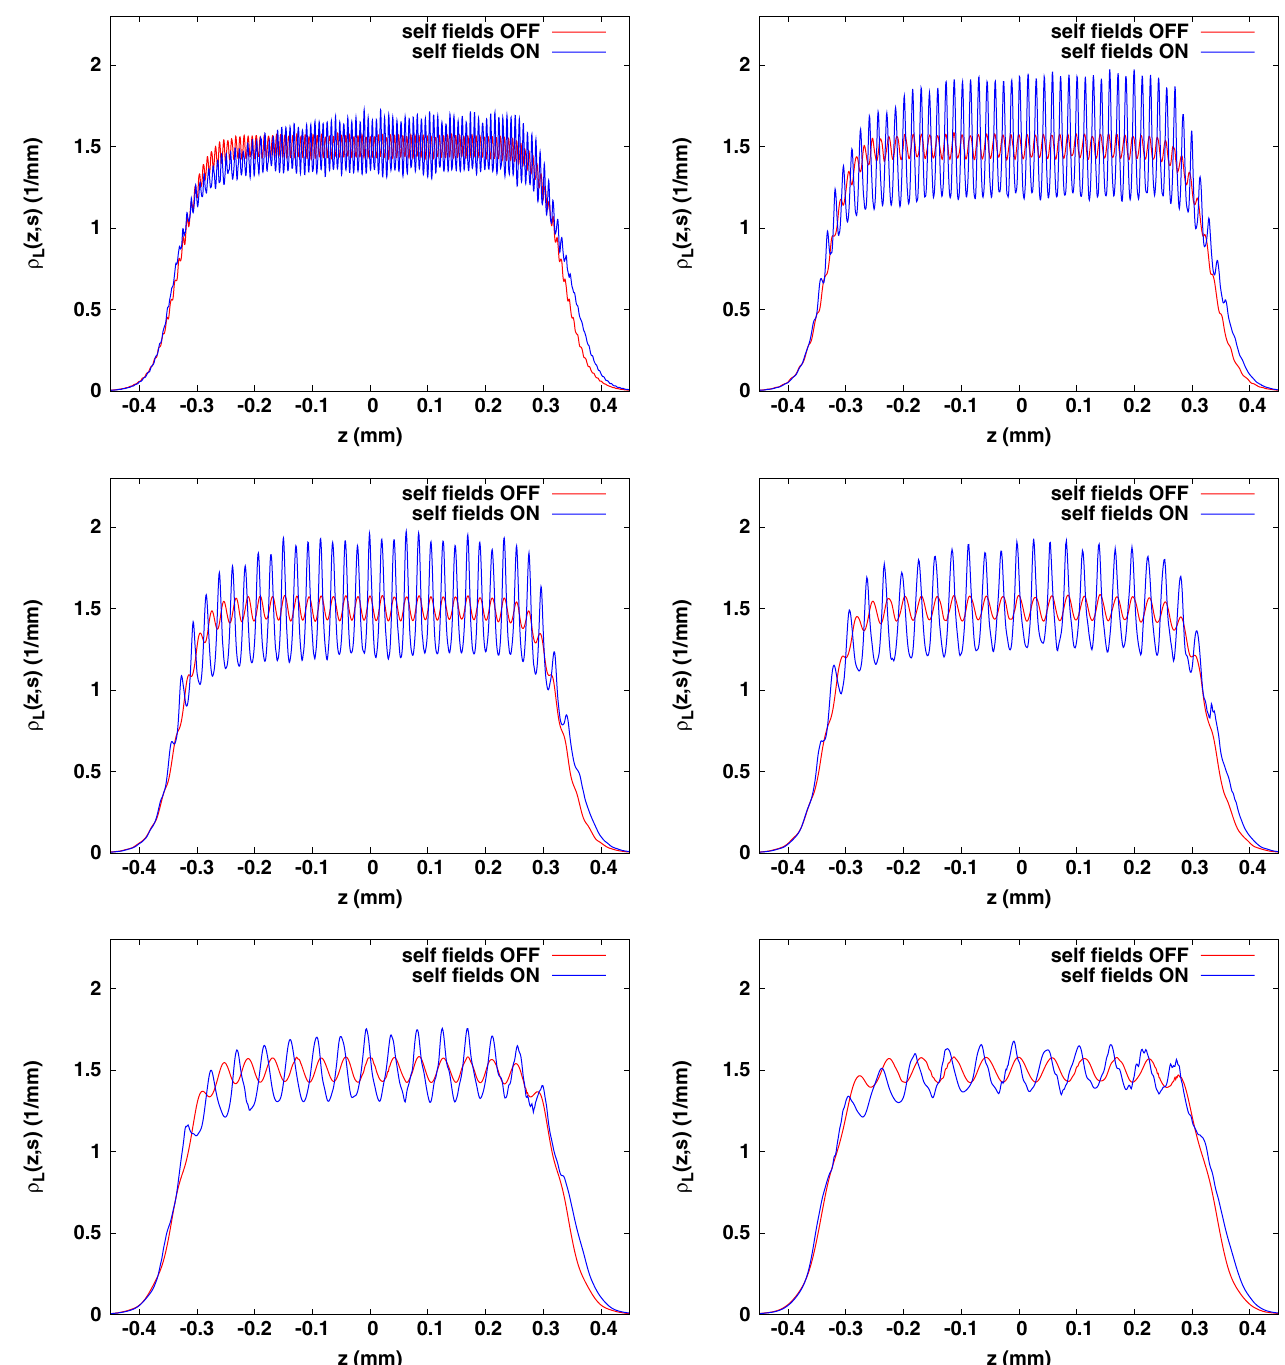
FIG. 22. Longitudinal density at the exit of the chicane with and without self-fields for (cid:8) ¼ 25 (cid:9) m (top left), (cid:8) ¼ 50 (cid:9) m (top right), (cid:8) ¼ 75 (cid:9) m (center left), (cid:8) ¼ 100 (cid:9) m (center right), (cid:8) ¼ 150 (cid:9) m (bottom left), and (cid:8) ¼ 200 (cid:9) m (bottom right). The results are obtained with the TWT method. We clearly see (top left) that the modulation wavelength (cid:8) ¼ 25 (cid:9) m leads to a mild microwave